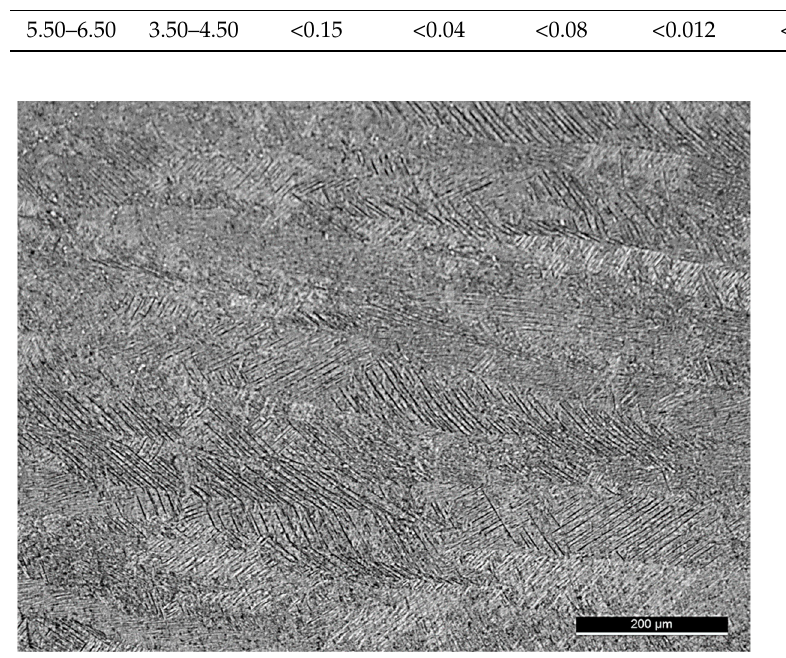
Table 1. Chemical composition of the titanium Ti-6Al-4V alloy (wt.%) [20]. Al V